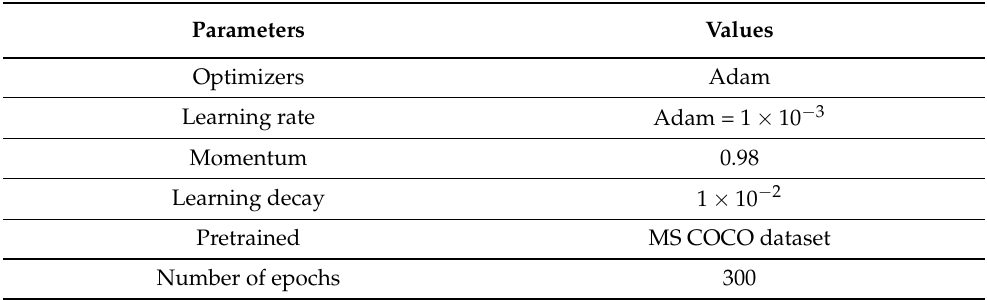
Table 1. Parameters used for training one-stage detector models such as YOLOv7, YOLOv5, YOLOv4, and YOLOv3.